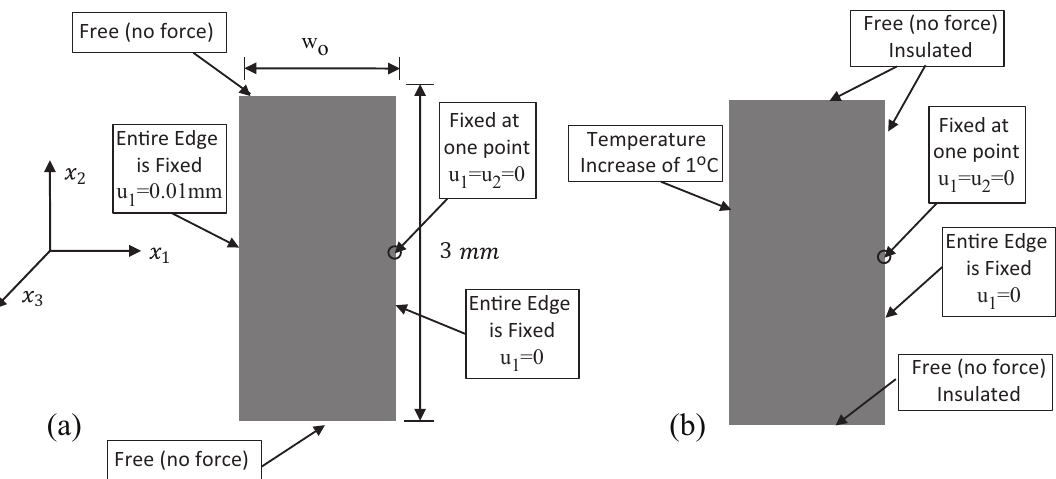
Figure 7. Boundary conditions for finite element analysis: ( a ) the tensile sample boundary conditions, and ( b ) the TMA boundary